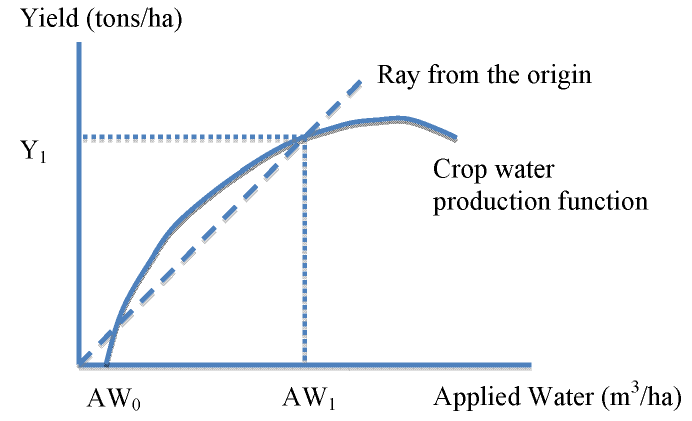
Figure 1. Depicting the water productivity of applied water in a typical crop water production function.